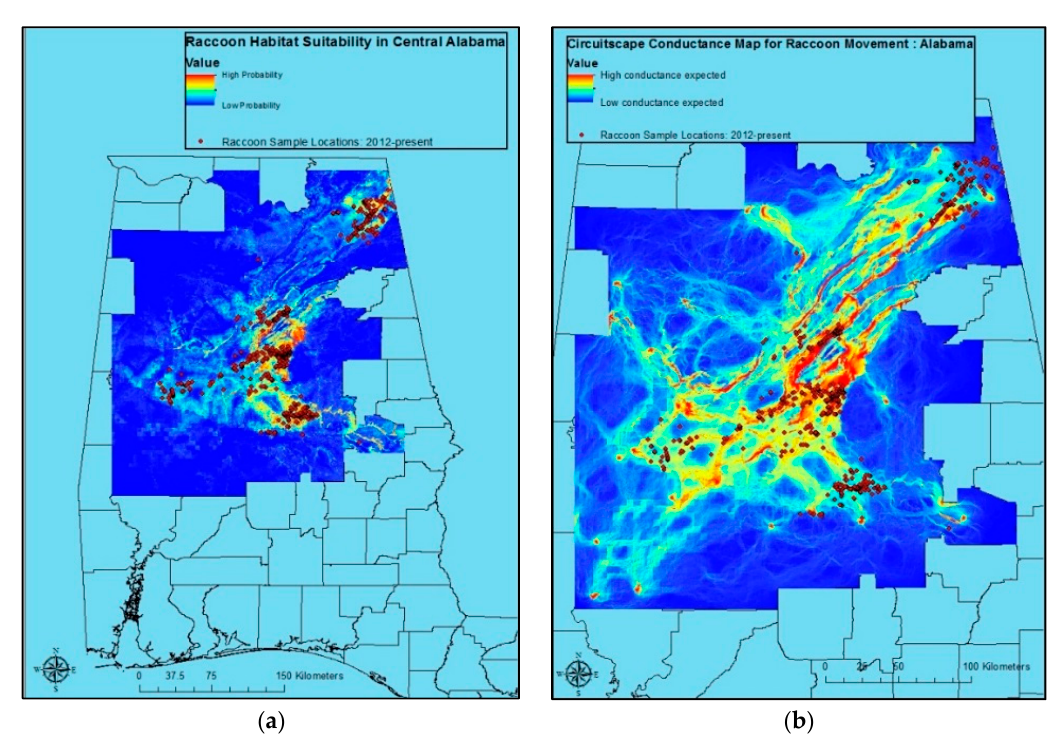
Figure 1. Maxent raccoon location probability map based on raccoon sample (( a ); n = 1168; 5 January 2012–